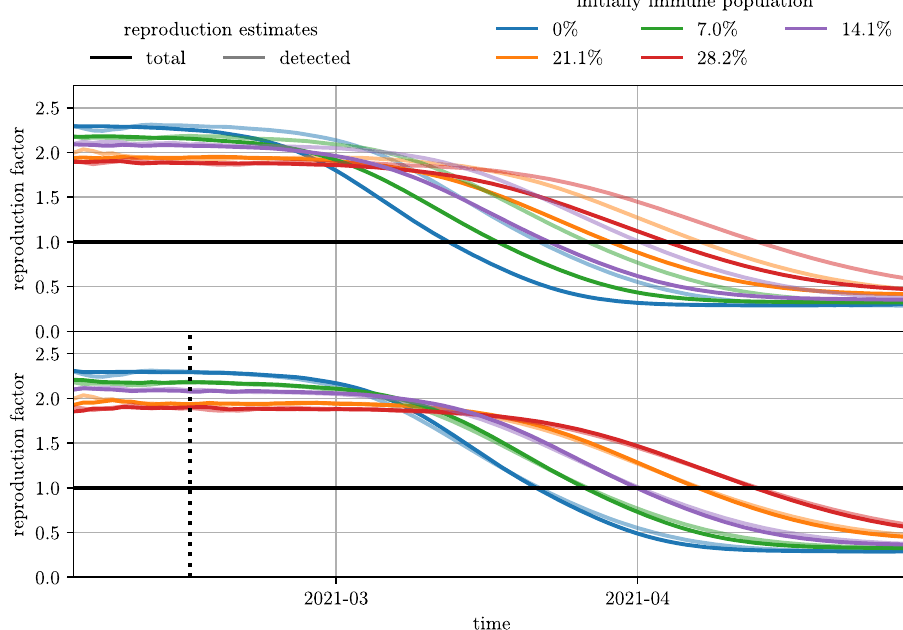
Figure 8. Estimates of the effective reproduction number for different initial immunization level. The effective reproduction number has been evaluated both on the total new cases as well as on the detected new cases. In the lower plot, the evaluation based on all new cases has been shifted to account for the time delay between infection and detection date. The black dotted line indicates the date (2021-02-14) used for evaluation of ˆ R det and eff